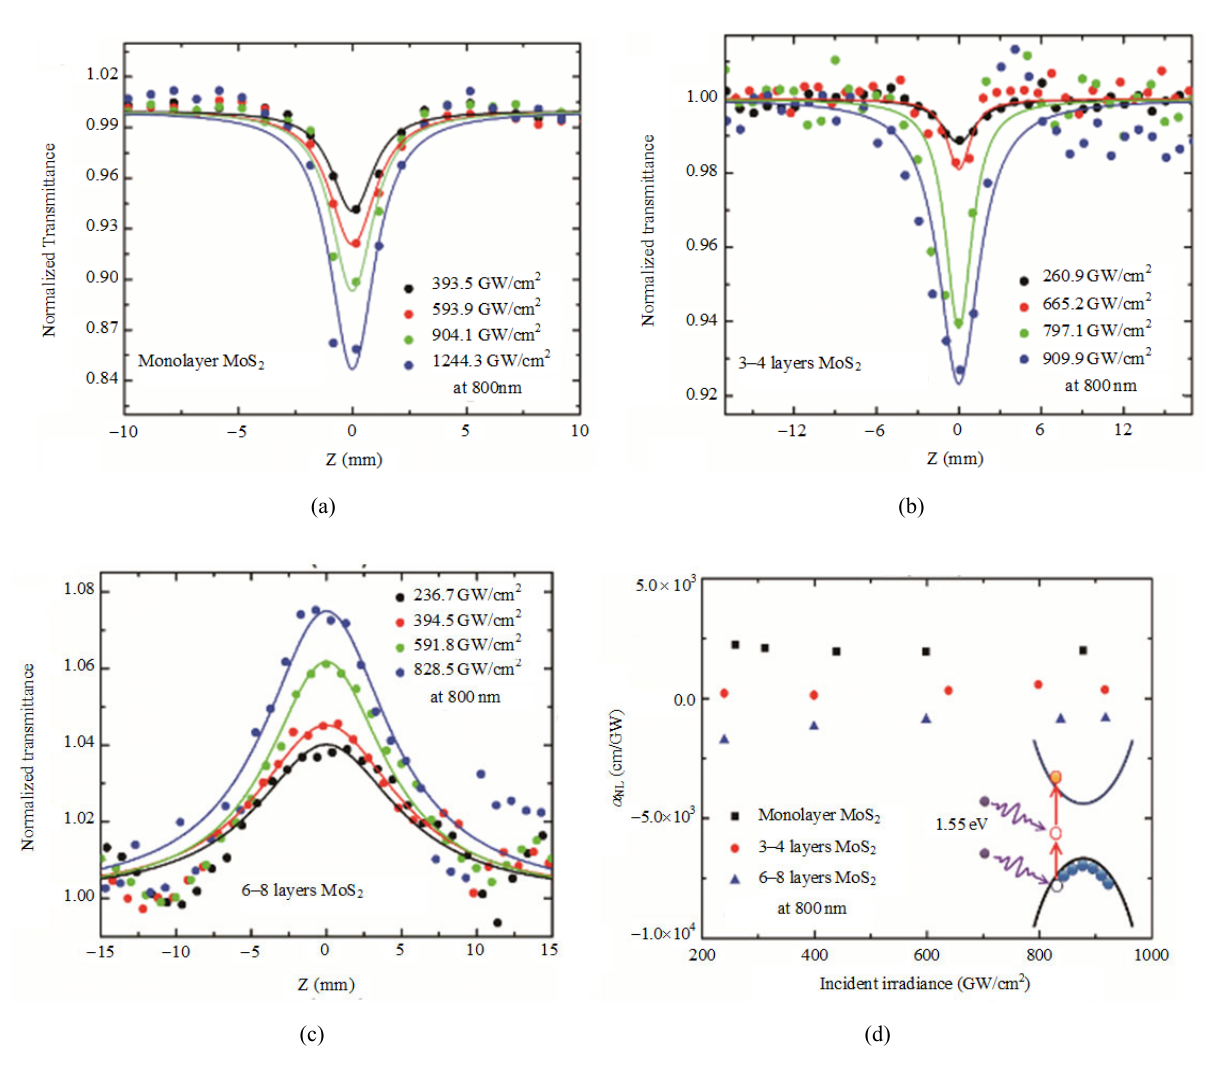
Fig. 3 OA Z-scan results of (a) monolayer, (b) 3 ‒ 4 layers, (c) 6 ‒ 8 layers MoS 2 . The dots are experimental data and solid lines are fitting data, and (d) The NLO absorption coefficients for MoS 2 films. Inset: schematic of SA process. An 800-nm excitation laser (65 fs) is